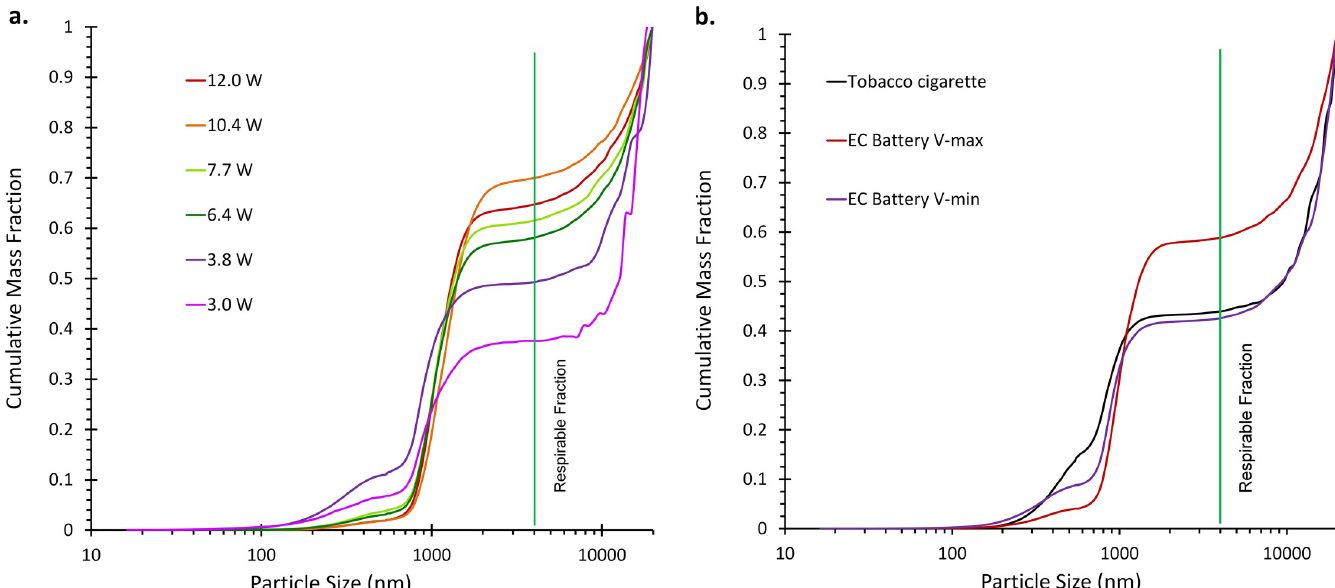
Fig 4. Cumulative mass fraction by size for EC aerosol and cigarette smoke. a.) EC aerosol generated with laboratory power supply at 9 levels. As power increases, a greater fraction of the mass is below 4 μ m which is within the respirable fraction, left of the vertical line. b.) Cigarette smoke (Kool Blue) and EC aerosol powered by a variable voltage EC battery at V min and V max dial settings. Respirable fraction of cigarette smoke and EC aerosol at minimum dial setting are very similar. Respirable fraction does not increase as greatly when powered by battery compared to laboratory power supply, this may be due to battery underperformance.